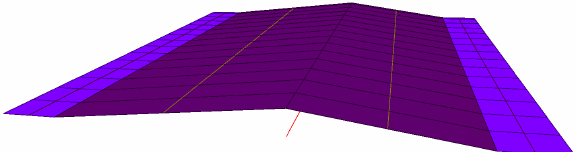
Figure 10. Gaps between the lane boundaries that exceed the orange colored tolerance.